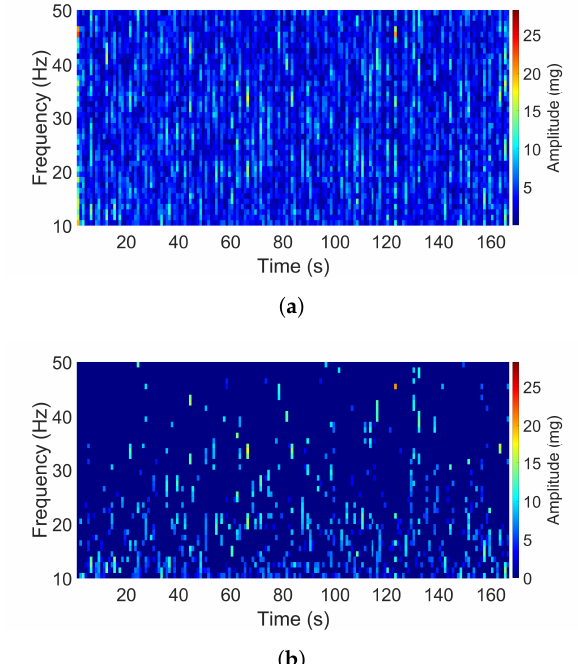
Figure 10. Spectrogram of the acoustic guitar signal (Z direction): ( a ) Original. ( b ) Filtered.